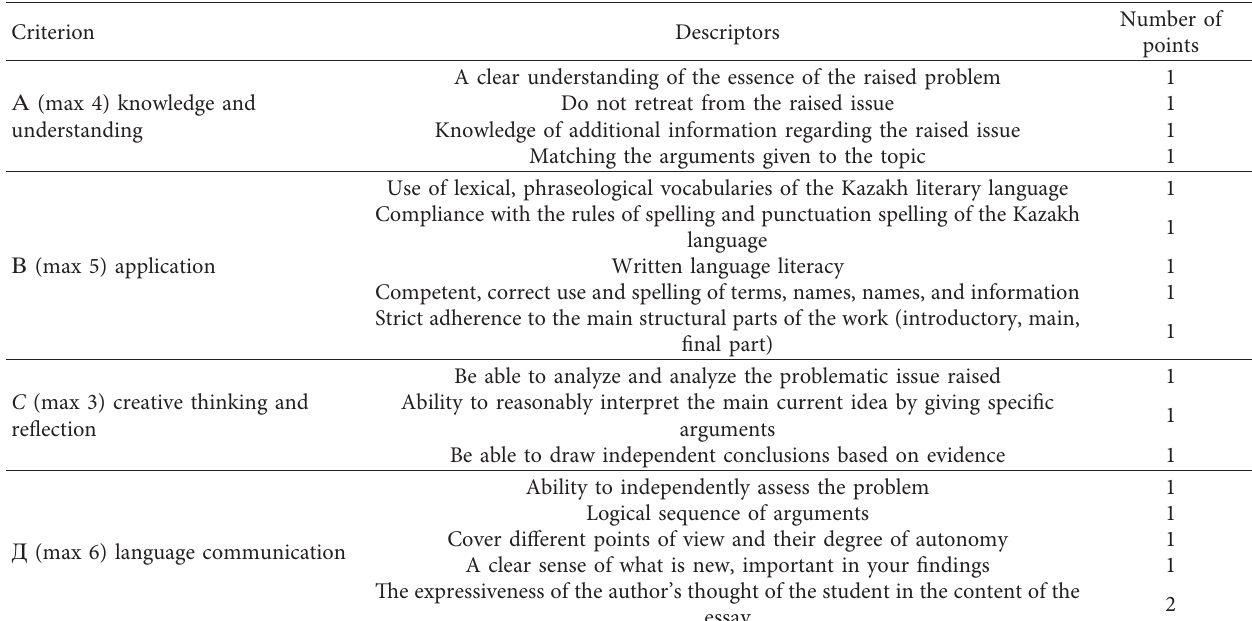
Table 4: Criteria for evaluating the essay.